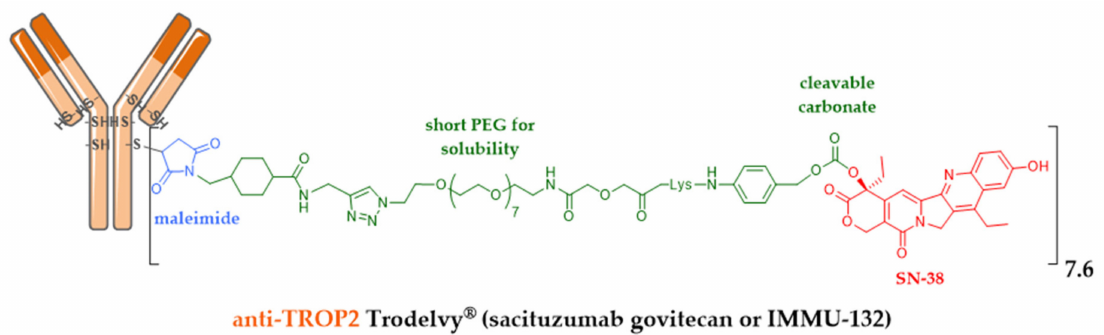
Figure 15. Trodelvy ® (sacituzumab govitecan or IMMU-132) formula, ADC with a DAR 7.6, resulting from anti-TROP-2 antibody conjugation to SN-38 via an acid-sensitive cleavable